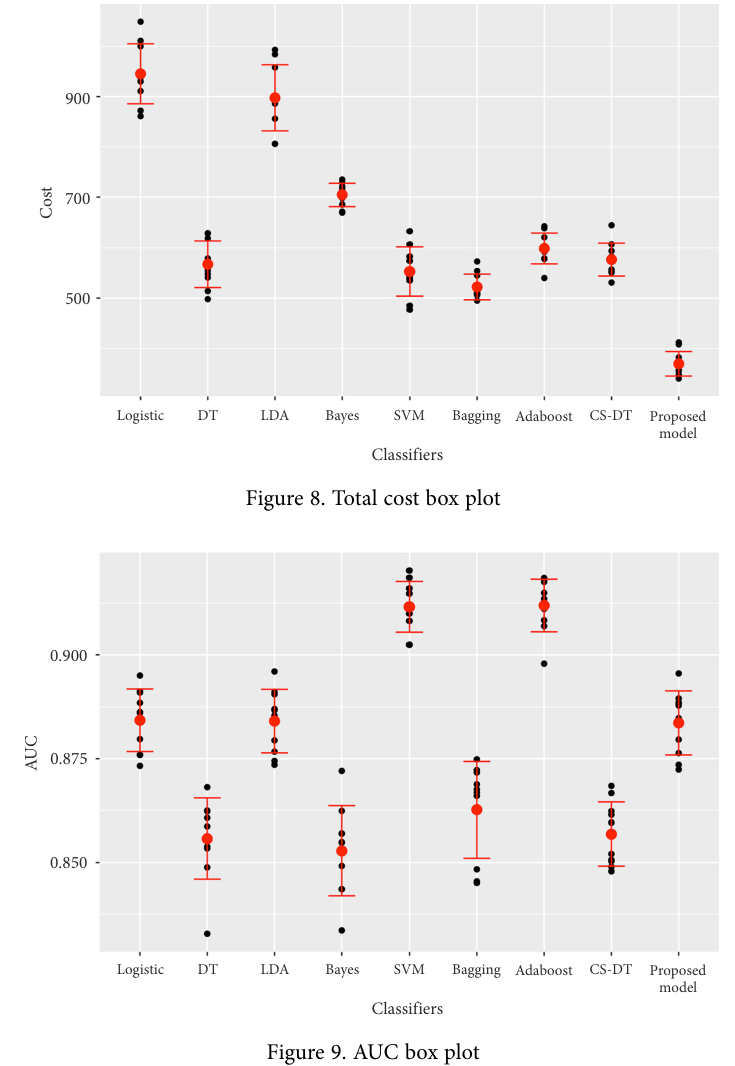
Figure 9. AUC box